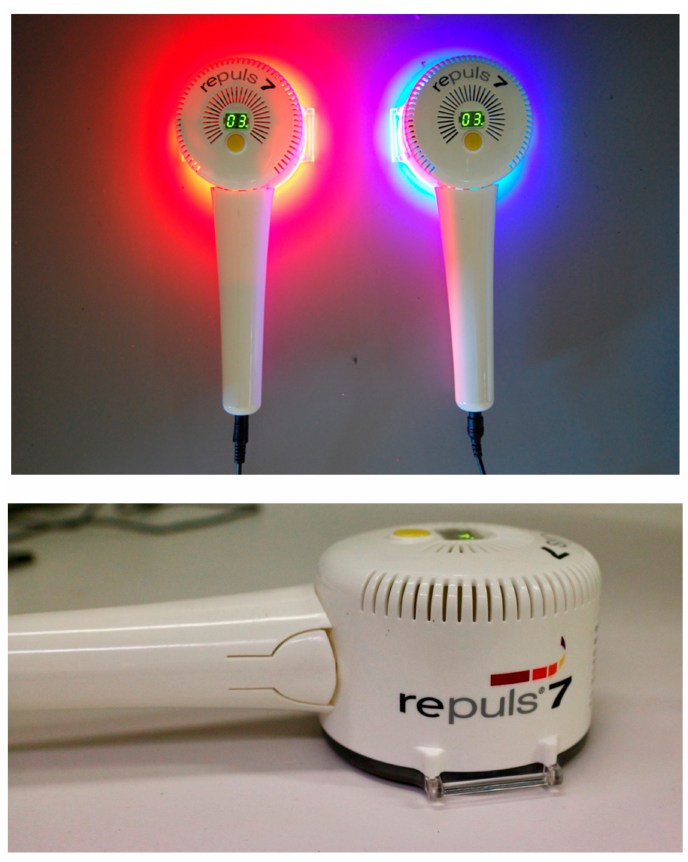
Figure 1. Repuls7PDI-red and -blue light emitting diode (LED) laser illumination